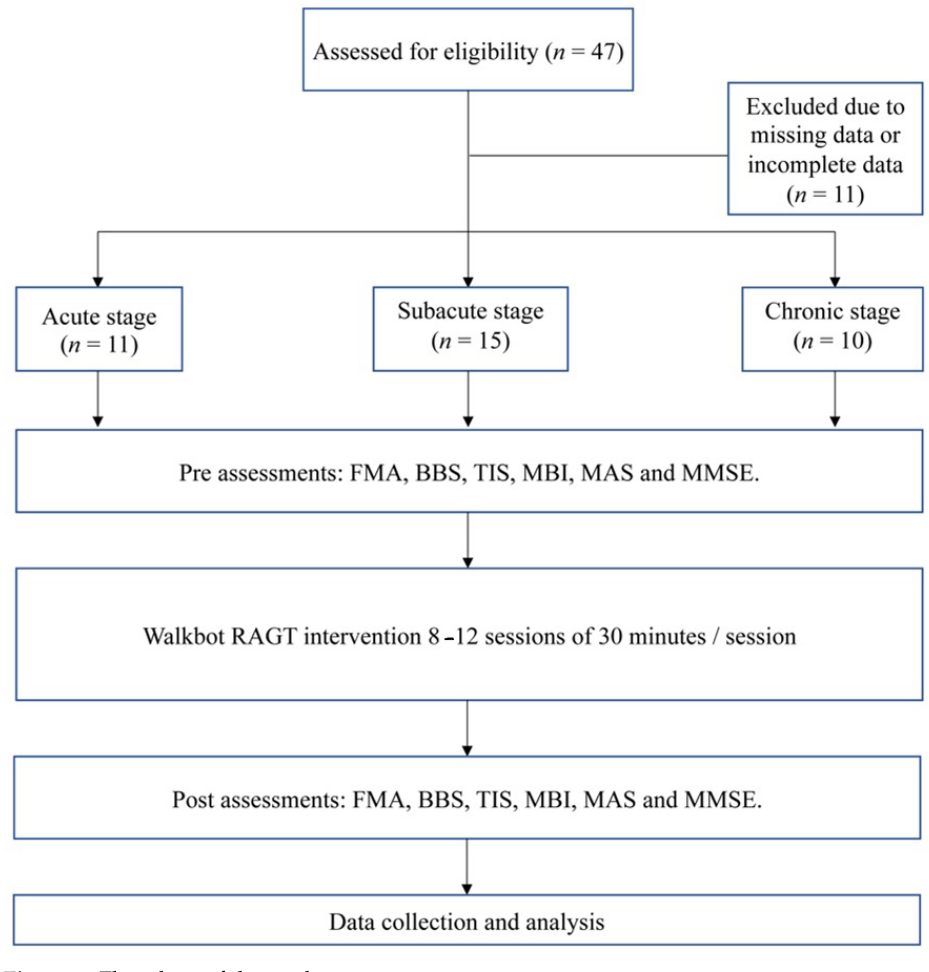
Figure 1. Flowchart of the